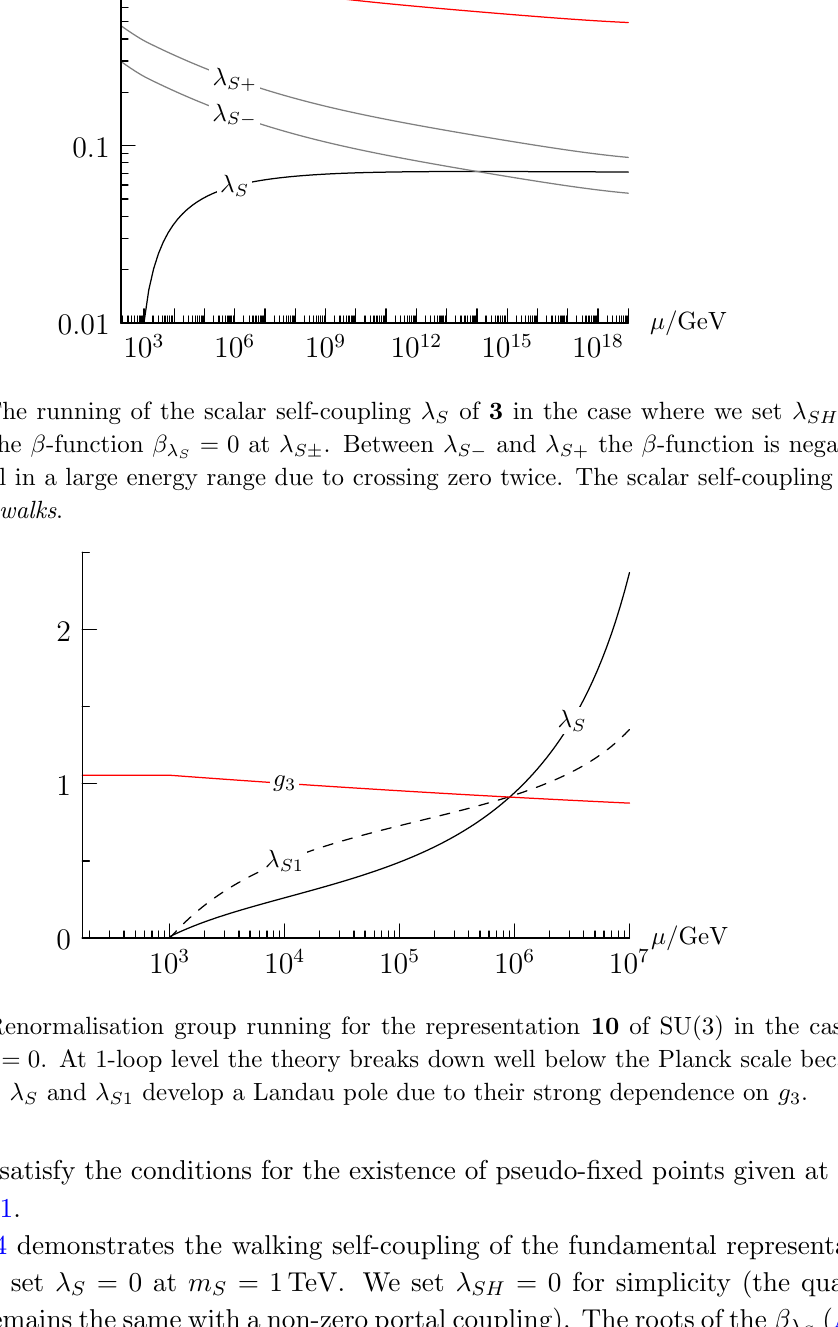
Figure 5 . Renormalisation group running for the representation 10 of SU(3) in the case where we take (cid:21) SH = 0. At 1-loop level the theory breaks down well below the Planck scale because the self-couplings (cid:21) S and (cid:21) S 1 develop a Landau pole due to their strong dependence on g 3 . (cid:12) -functions satisfy the conditions for the existence of pseudo-(cid:12)xed points given at the